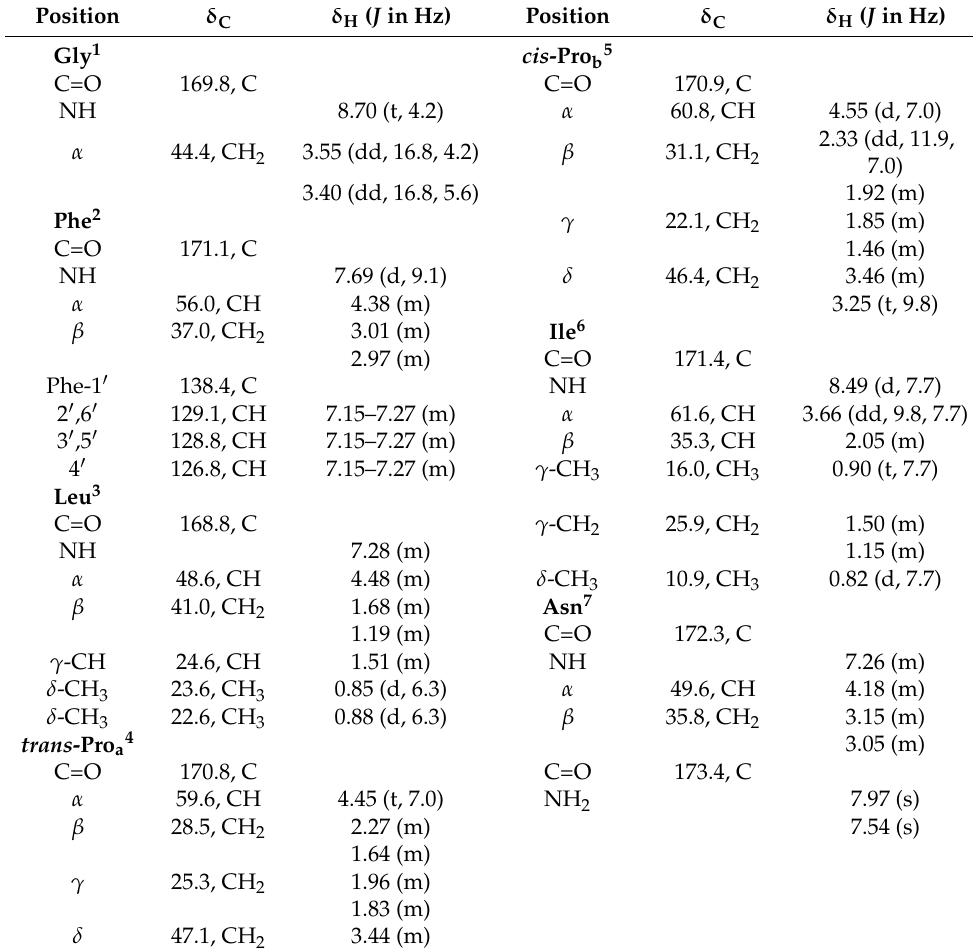
Table 1. 1 H and 13 C NMR data for dianthiamide A ( 1 ) (DMSO- d 6 , 700 MHz, d in ppm, J in